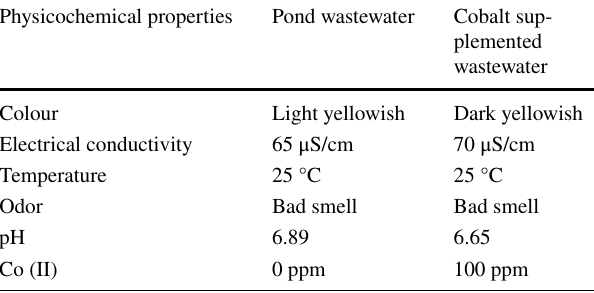
Table 1 Summary of physicochemical analysis of inoculation source Physicochemical